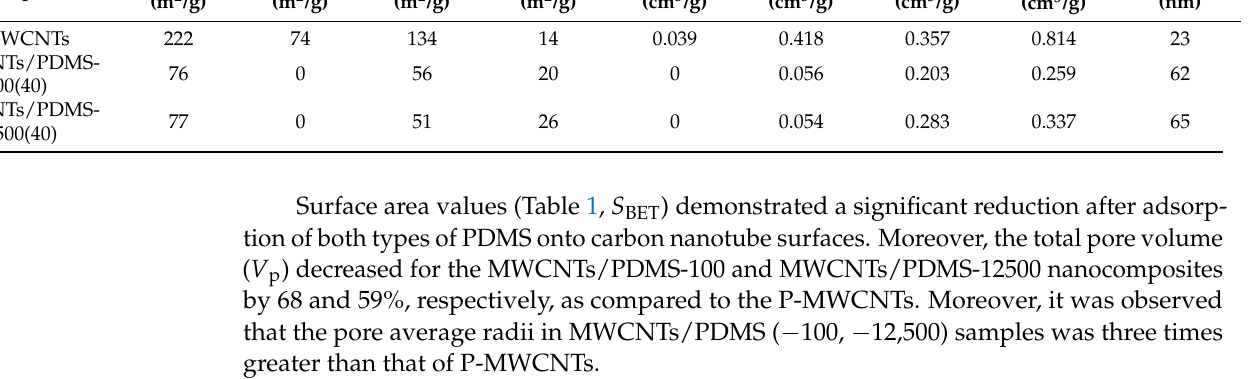
Figure 1. ( a ) Nitrogen adsorption–desorption isotherms and ( b ) incremental pore size distributions for P-MWCNTs (curve 1 ) and MWCNTs/PDMS nanocomposites (curves 2 , 3 ). The incremental pore size distribution IPSD functions (Figure 1b) show that the tex- Table 1. Textural characteristics of P-MWCNTs and MWCNTs/PDMS nanocomposites. tural porosity of the pristine MWCNT resulted from mesopores and secondly due to